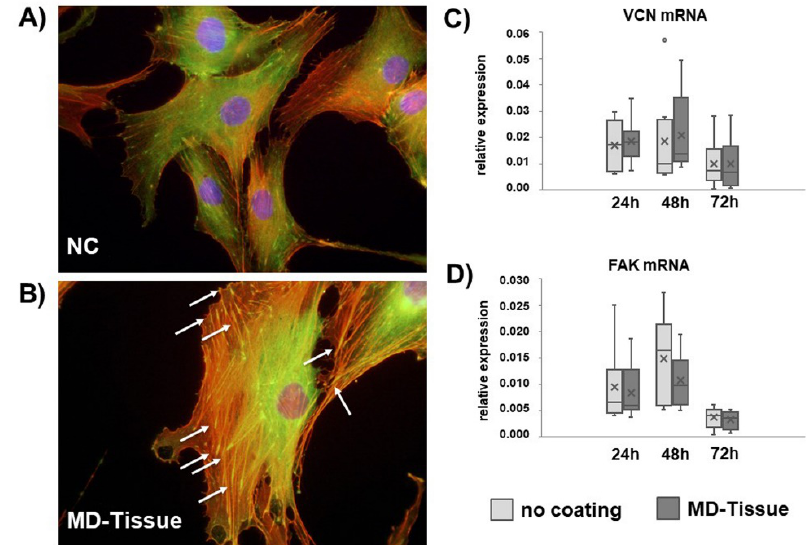
Figure 7. Immunofluorescence analysis for vinculin (green) in control tenocytes (NC) ( A ) and tenocytes cultured on MD-Tissue ( B ). Actin filaments are stained using rhodamine-phalloidin labeling. Nuclei are stained in blue by DAPI. Original magnification: 60×. Bar graphs showing VCN ( C ) and FAK ( D ) gene expression relative to GAPDH mRNA levels in NC and MD-Tissue tenocytes (COL). Data obtained from the eight samples are expressed as mean ± SD. ×: mean; •: outlier sample.